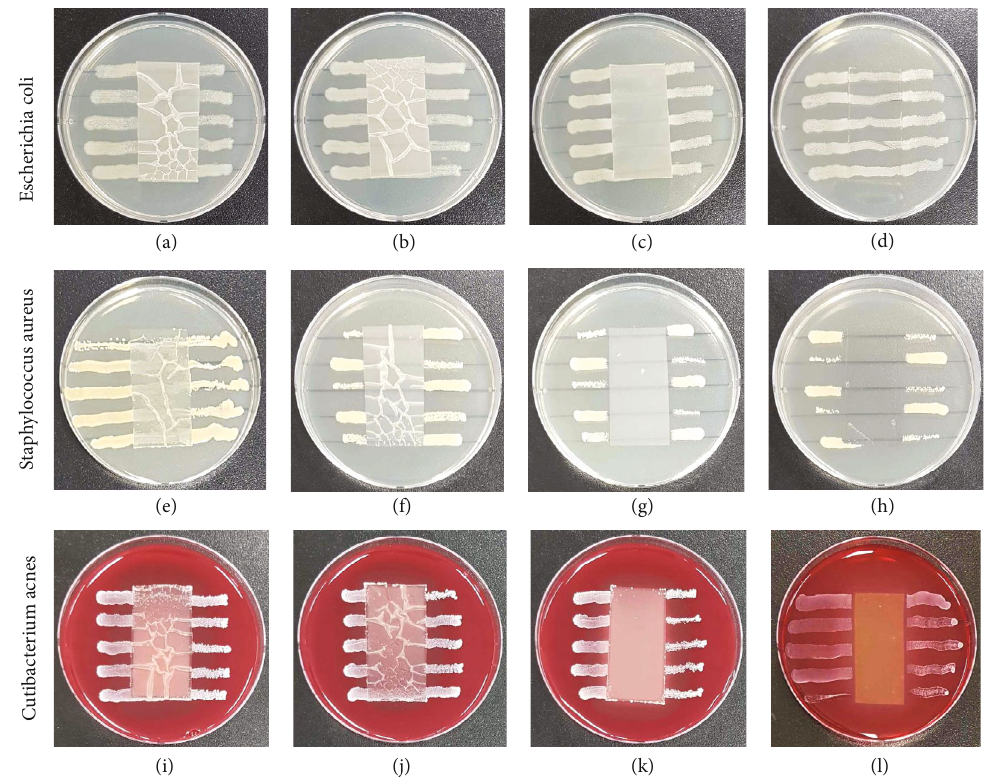
Figure 6: Antibacterial result of PVA nano fi bers with di ff erent relative concentrations of ZnO nanoparticles: (a, e, i) 0%, (b, c, j) 1%, (c, g, k) 4%, and (d, h, l) 7% each against (a – d) E. coli , (e – h) S. aureus , and (i – l) C. acnes . Table 1: Size of the clear zone in mm about each bacterium.